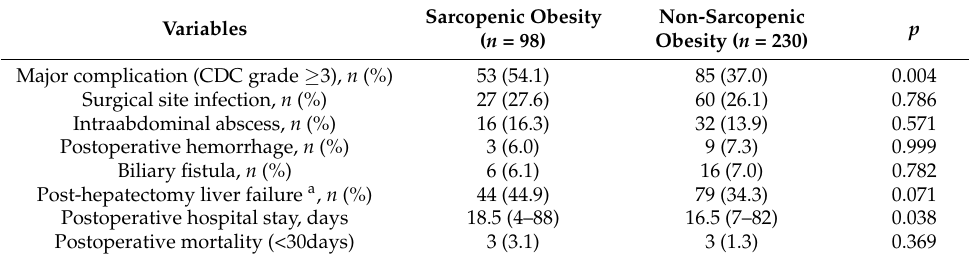
Table 2. Postoperative complications between the sarcopenic obesity and non-sarcopenic obesity